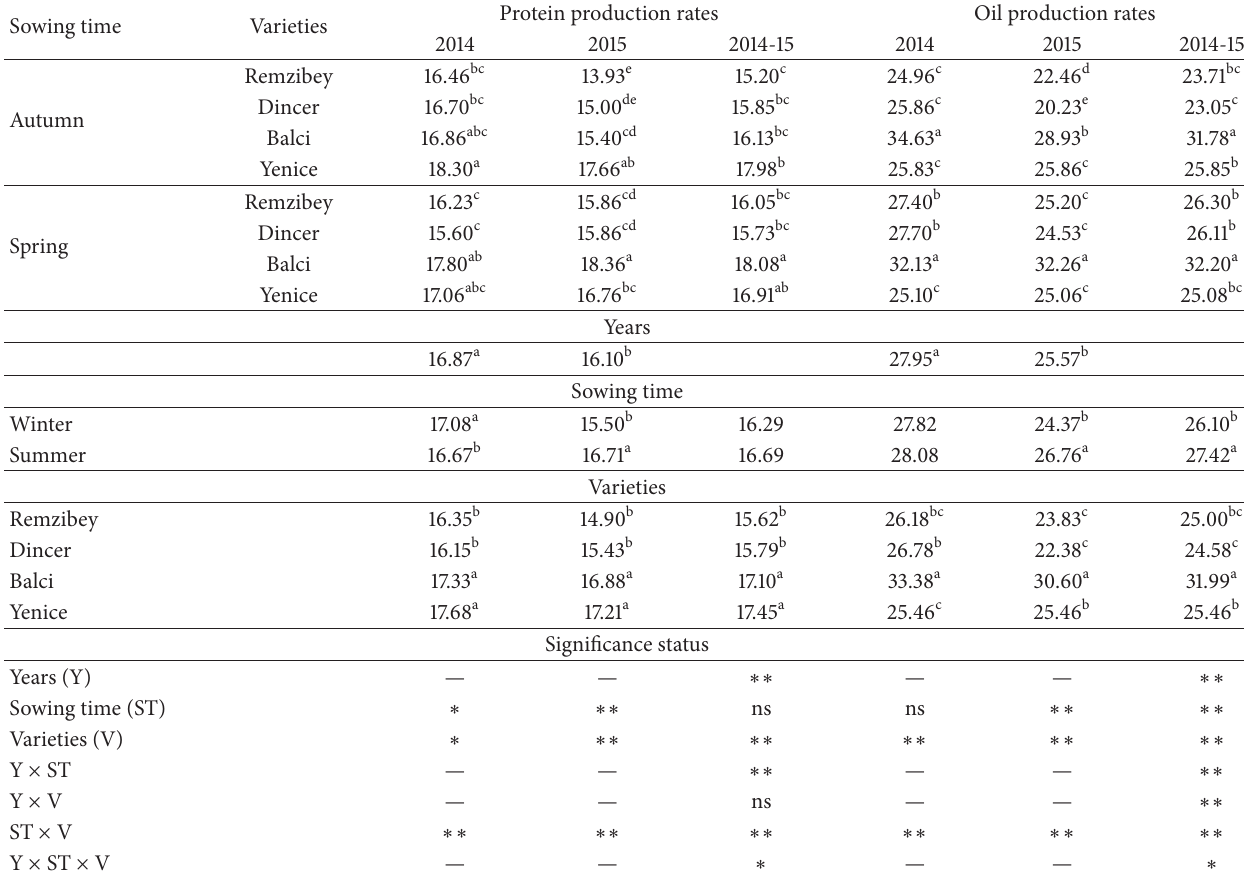
Table 1: Protein and oil rates of safflower seeds sown in the autumn and